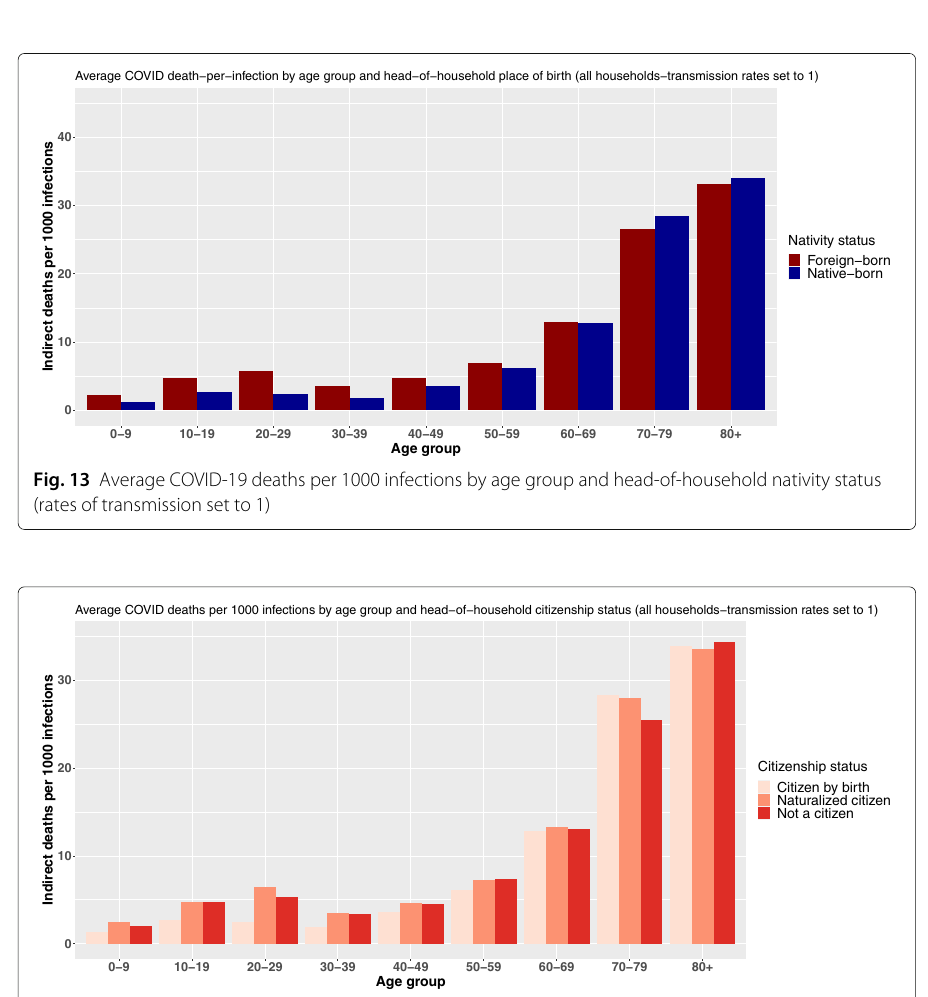
Fig. 14 Average COVID-19 deaths per 1000 infections by age group and head-of-household citizenship status (rates of transmission set to